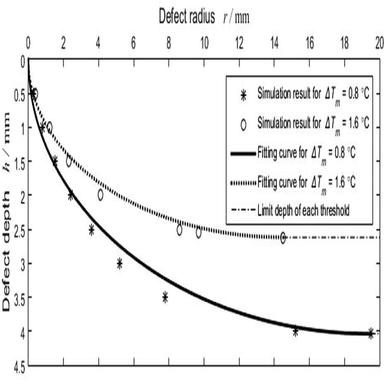
Differential temperature contour map using elliptic curve fitting forq = q0 = 2.0 × 106 W/m2.